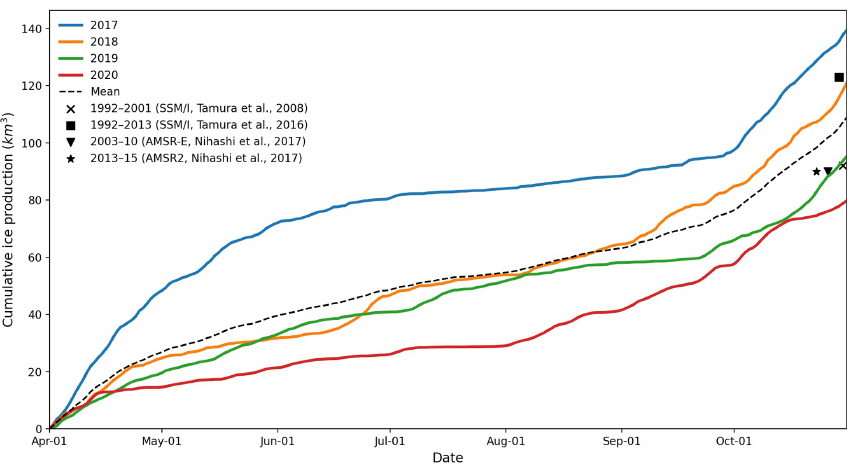
Figure 6. Daily cumulative winter ice production for each winter (April–October) 2017–2020 (solid), and the 4-year mean for the period (dashed), as measured using heat flux modeling of ERA-5 data and AMSR-2 SIC data. Also shown are mean annual measurements for 1992–2001 (Tamura et al., 2008), 1992–2013 (Tamura et al., 2016), and 2003–2010 and 2013–2015 (Nihashi et al., 2017), along with the instrument used for each measurement. Note the previous studies’ measurements covered the period March–October and used a study area that does not exactly correspond to ours.